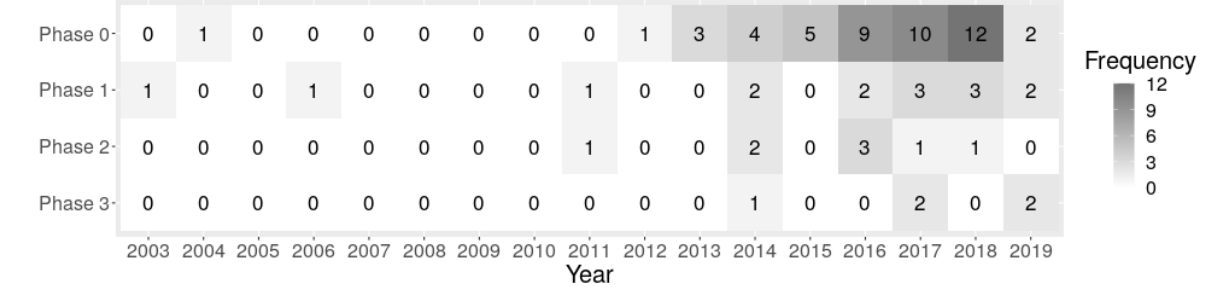
Figure 2. Overview of current and completed system and project phases per year.